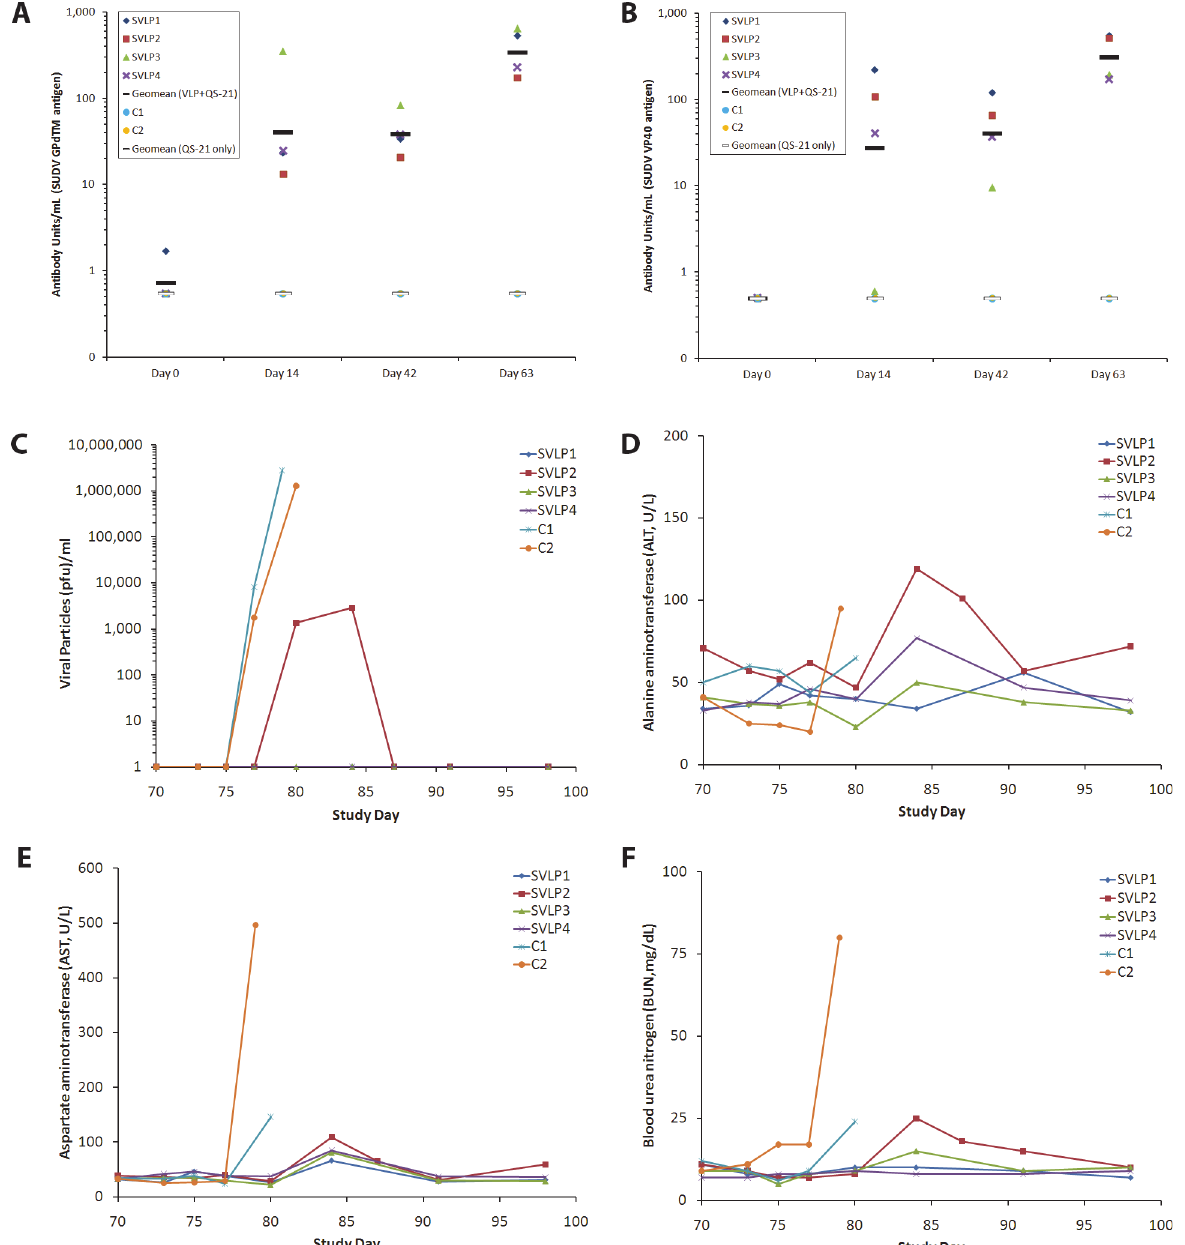
Fig 1. Serology responses following SUDV VLP + QS-21 (SVLP) or QS-21 only (Control, C) vaccination and clinical laboratory analysis following virus challenge. (A-B) Antibody titers from vaccinated animals were measured using the purified SUDV GPdTM (A) or VP40 (B) IgG ELISA. The data are expressed as the antibody units for each animal at each time point and the geometric mean for each group is shown by the lines, as indicated in the figure legends. (C) Infectious virus detectable in the sera of NHPs challenged with SUDV on study day 70 was determined using a standard plaque assay; data are represented as the values for individual monkeys. (D-F) Serum samples were collected at multiple time points during the challenge portion of the study and assayed for clinical chemistry/enzymatic levels including (D) alanine aminotransferase, (E) aspartate aminotransferase, and (F) blood urea nitrogen.